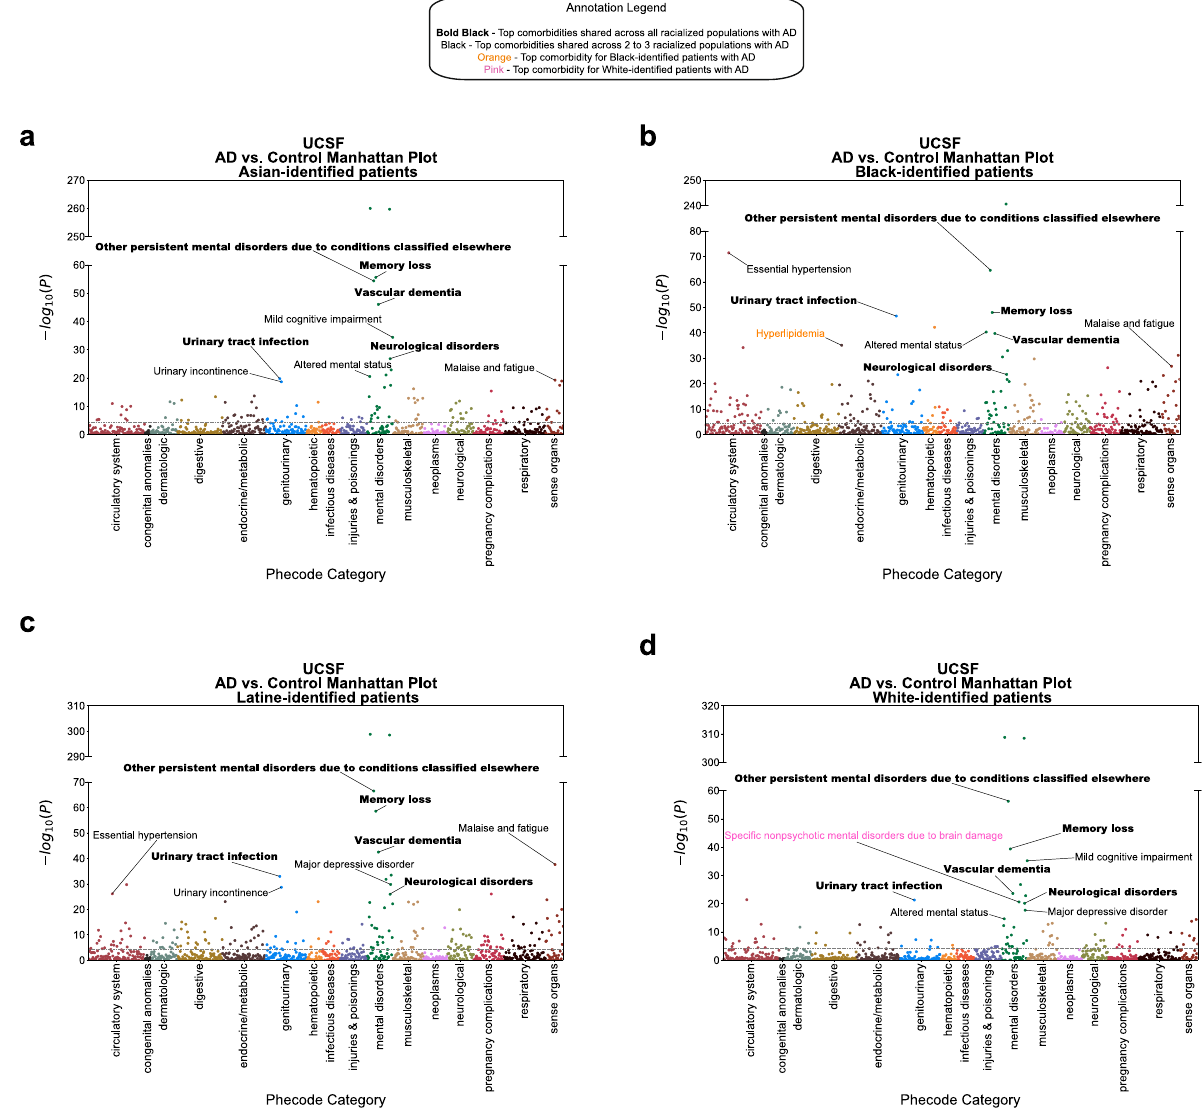
Fig. 4 Differential analysis reveals that top signi fi cant comorbidities often overlap for multiple racialized populations with AD. Manhattan plots of signi fi cant comorbidities, represented as phecode-corresponding phenotypes, colored by phecode categories, for ( a ) Asian-, ( b ) Black-, ( c ) Latine-, and ( d ) White- identi fi ed patients with AD. Statistical signi fi cance was determined using two-sided Fisher ’ s exact or chi-squared tests, comparing 931 phenotypes between patients with AD ( n = 422) and control patients ( n = 844) within each racialized population at UCSF. Signi fi cance corresponds to a Bonferroni- corrected p -value < 0.05. Nine of the most signi fi cant comorbidities are annotated. Bold black annotation = top signi fi cant comorbidities shared by all racialized populations; black annotation = top signi fi cant comorbidities shared by multiple racialized populations; orange annotation = one of the top signi fi cant comorbidities for Black-identi fi ed patients; pink annotation = one of the top signi fi cant comorbidities for White-identi fi ed patients.